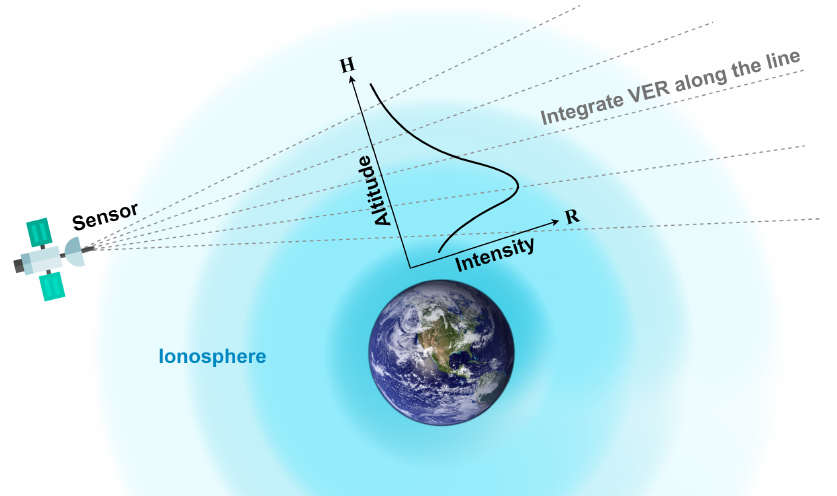
Figure 3. Geometry of the Abel inversion for transforming emission intensity (Rayleigh) into VER at the tangent